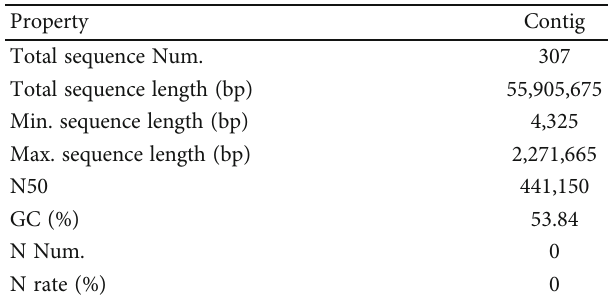
Table 1: Statistics for the fi nal assemblies of the H. coralloides genome. Total sequence Num.